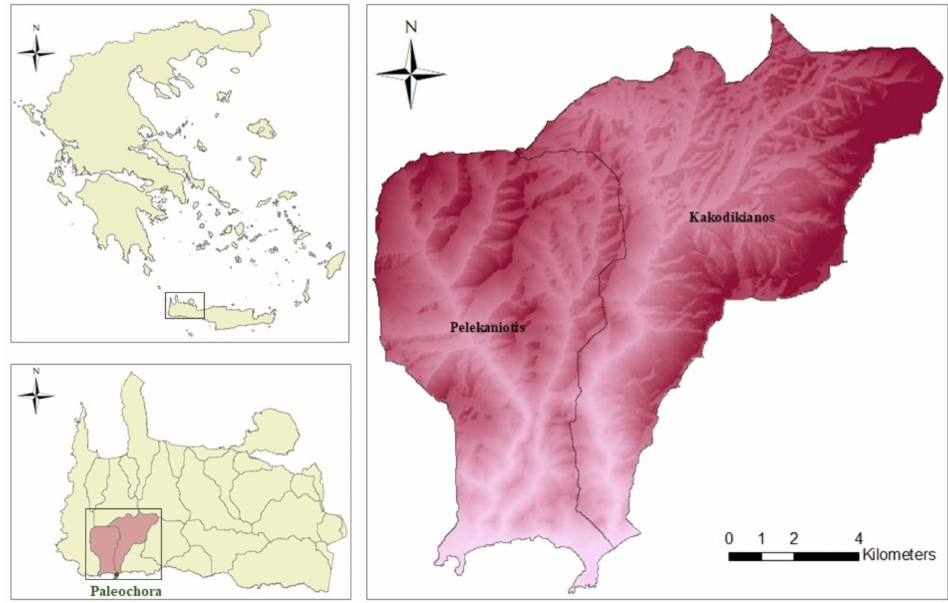
Figure 1. Shaded relief map of the study